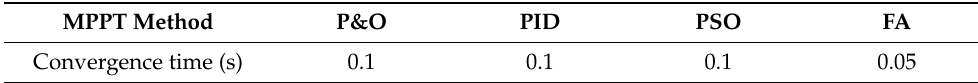
Table 9. Performance comparison of FA, P&O, PID and PSO (Case